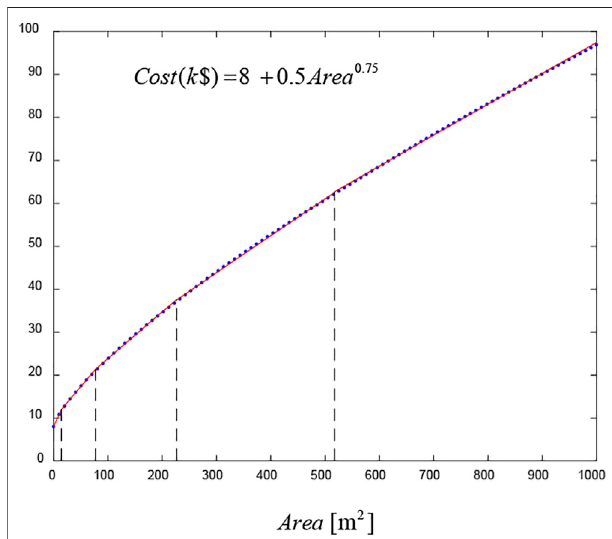
FIGURE 2 | Example of piecewise approximation of the cost function using 5 linear intervals. Note that the intervals are not equally distributed, but are calculated to minimize the approximation error. Dots are actual values used to approximate the cost and lines are the linear